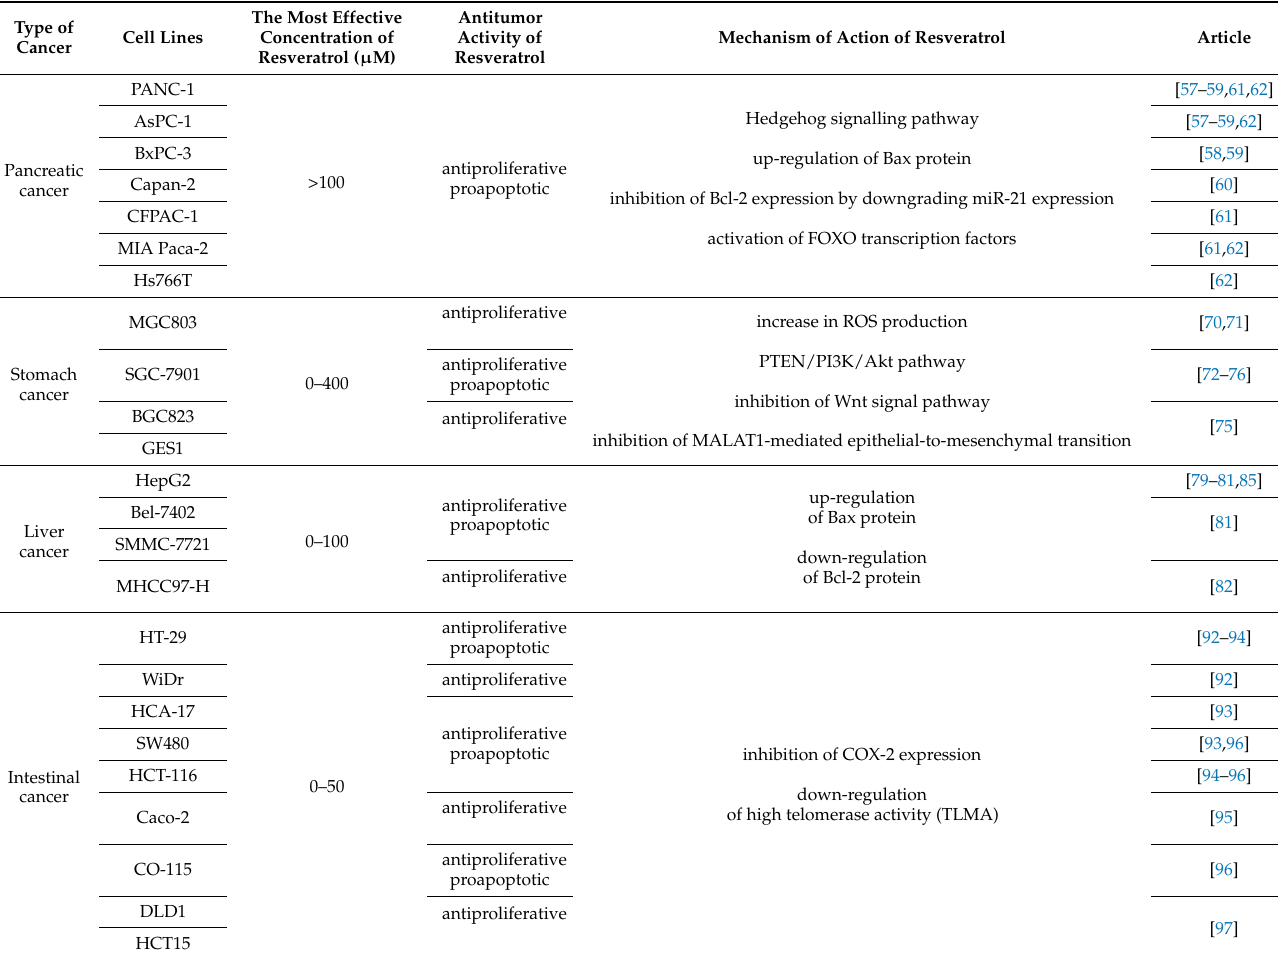
Table 1. List of different cancer cell lines in each type of